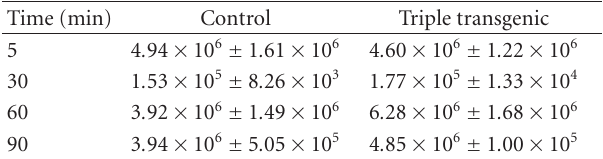
Table 4: 12 months triple transgenic Mice with 125 ICQ BCA NPs in DLU/mm 2 (mean ± SD); ( n = 2).